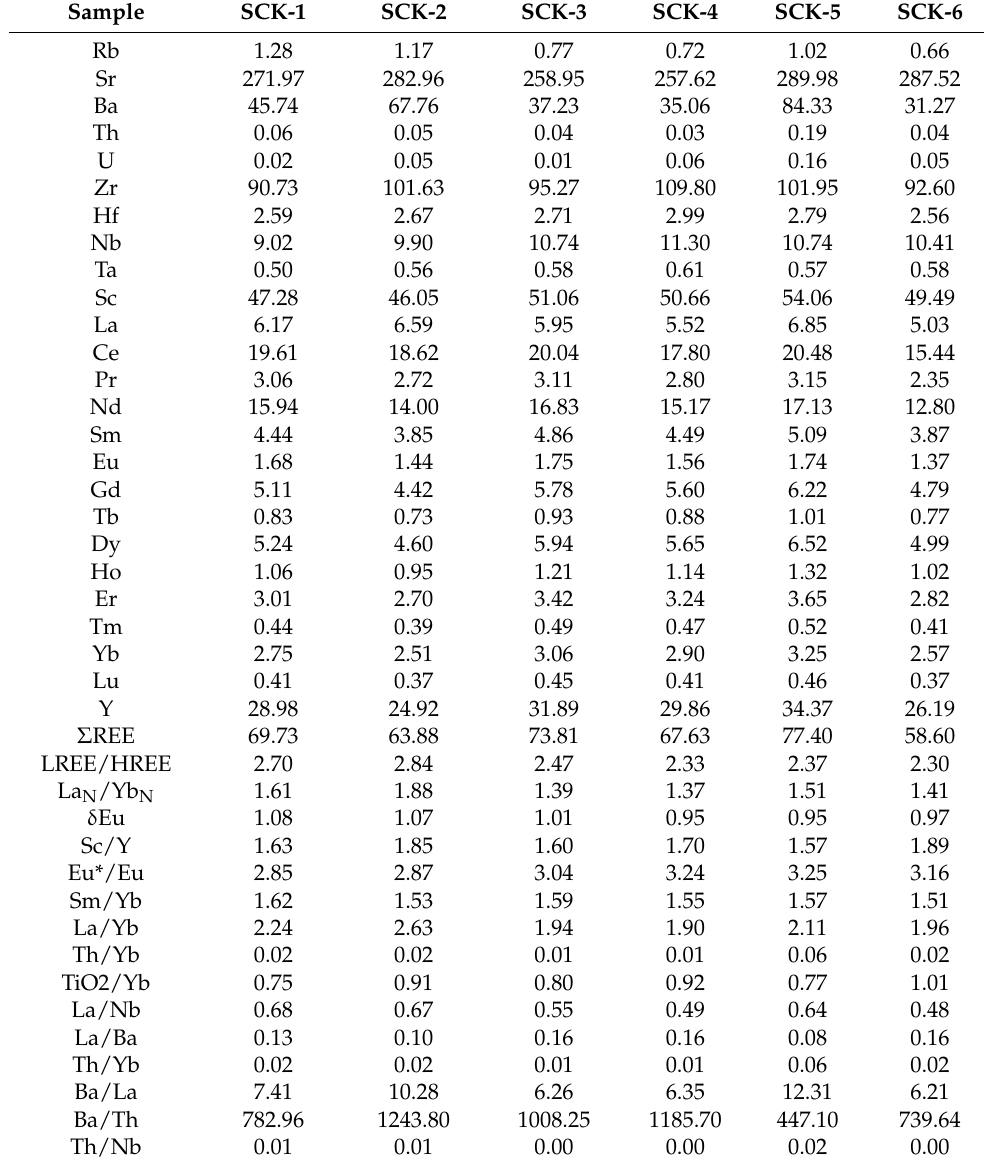
Table 5. The whole-rock trace elemental data ( × 10 − 6 ) of the Sanchakou gabbros.